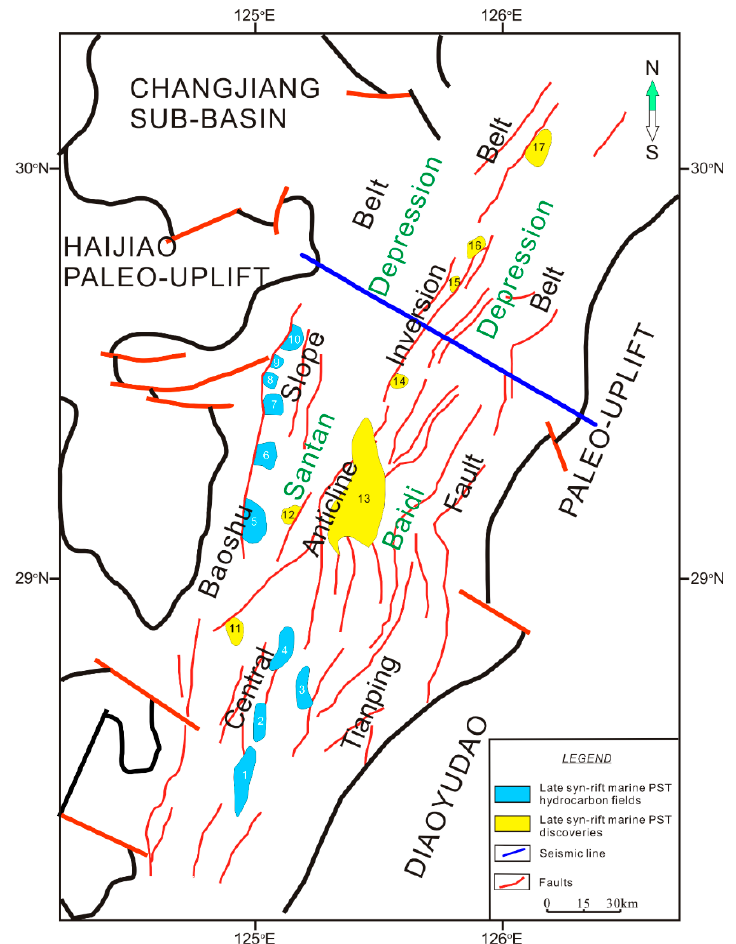
Figure 6. Structural units of the Xihu Sub-basin (West Shelf Basin). Location of major hydrocarbon fields and hydrocarbon-bearing structures and their PSTs are also indicated in the map. Note that all belong to the late syn-rift marine PST. 1 = Chunxiao field; 2 = Tianwaitian field; 3 = Duanqiao field; 4 = Canxue field; 5 = Pinghu field; 6 = Baoyunting field; 7 = Wuyunting field; 8 = Wubei field; 9 = Laiheting field; 10 = Kongqueting field; 11 = Gushan 1 discovery; 12 = Qiuyue 1 discovery; 13 = Yuquan discovery; 14 = Huagang 1 discovery; 15 = Longjing 1 discovery; 16 = Longjing 2 discovery; 17 = Longjing 4 discovery.